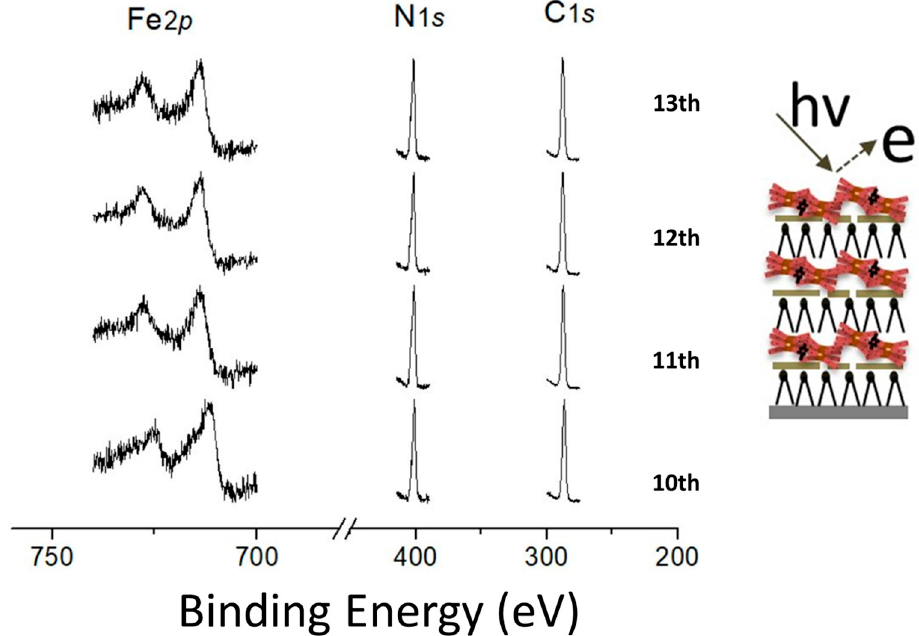
Figure 3. X-ray photoemission spectra of the Fe2 p , N1 s , and C1 s (used as reference) core level regions collected from 10- to 13-layer-thick DODA-clay-Fe/POSS hybrid films.